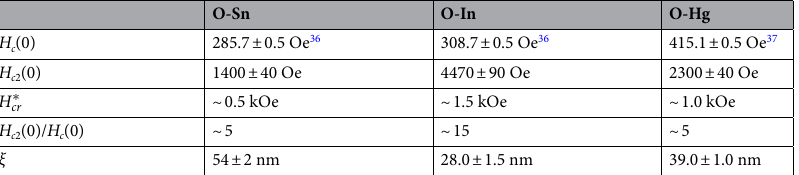
Table 1. Critical fields H c (0) for bulk metals used in the nanocomposites, calculated upper critical fields H